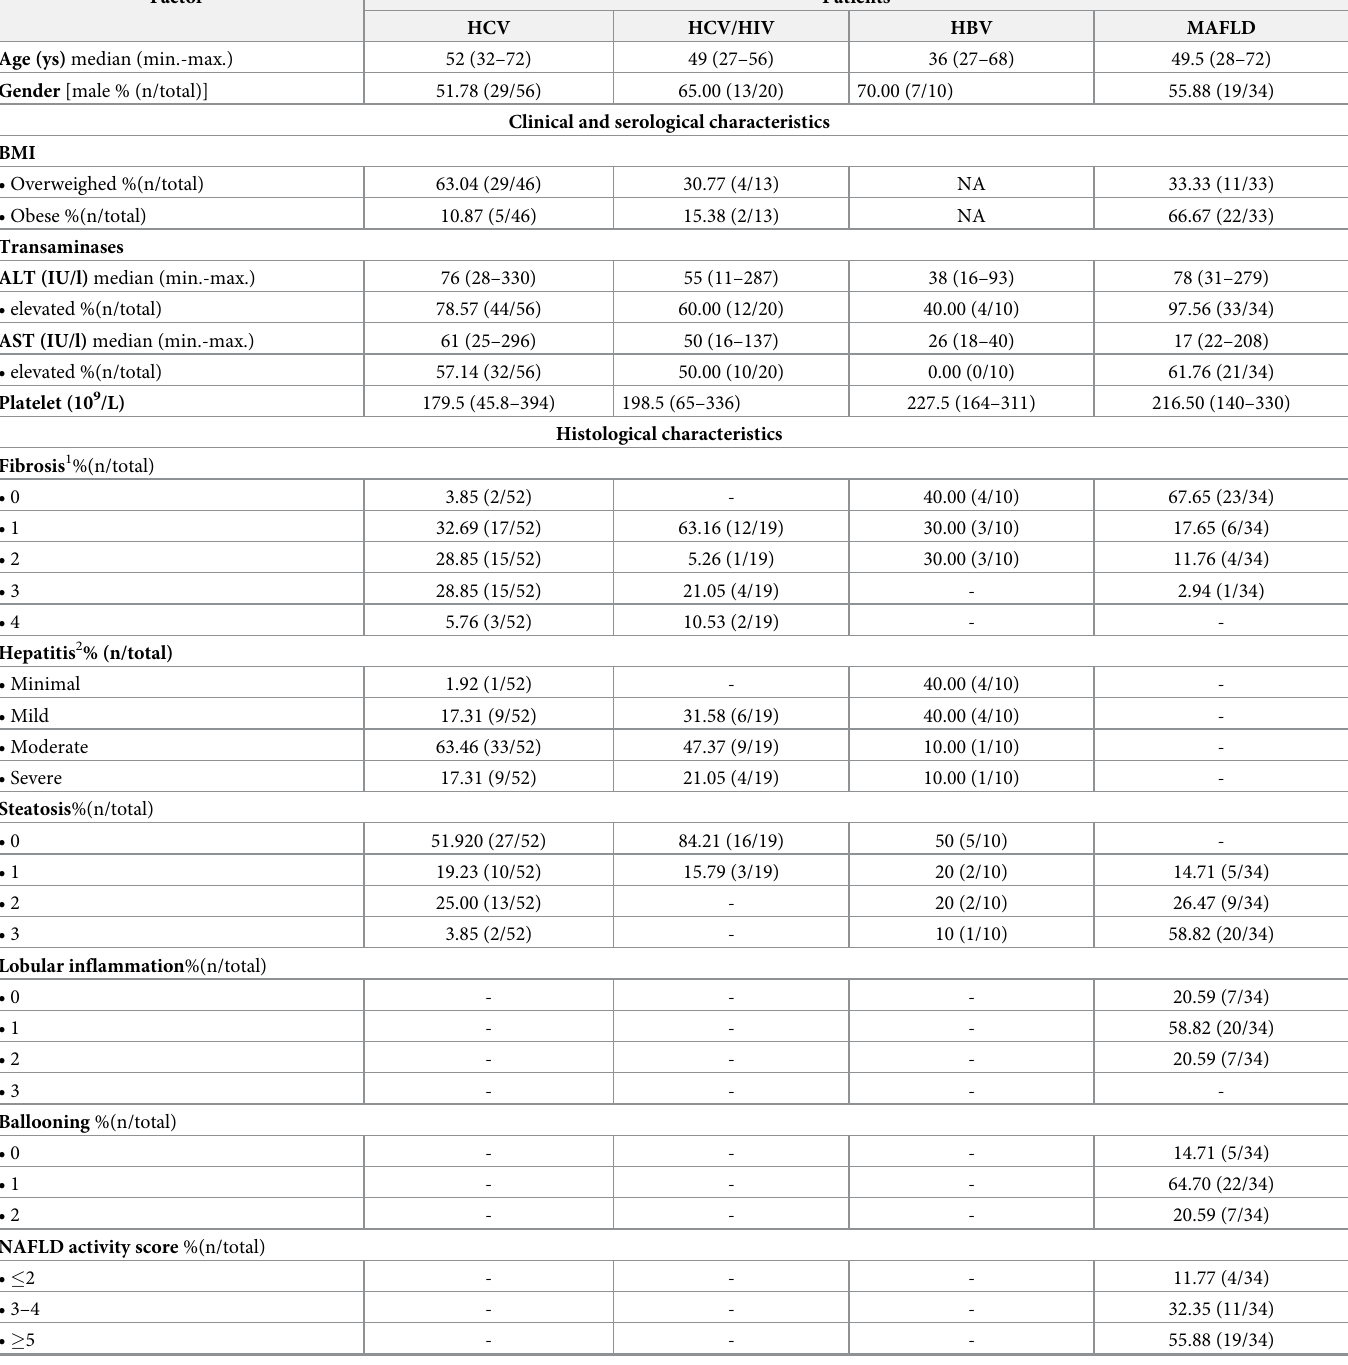
Table 1. Clinical and histological patient